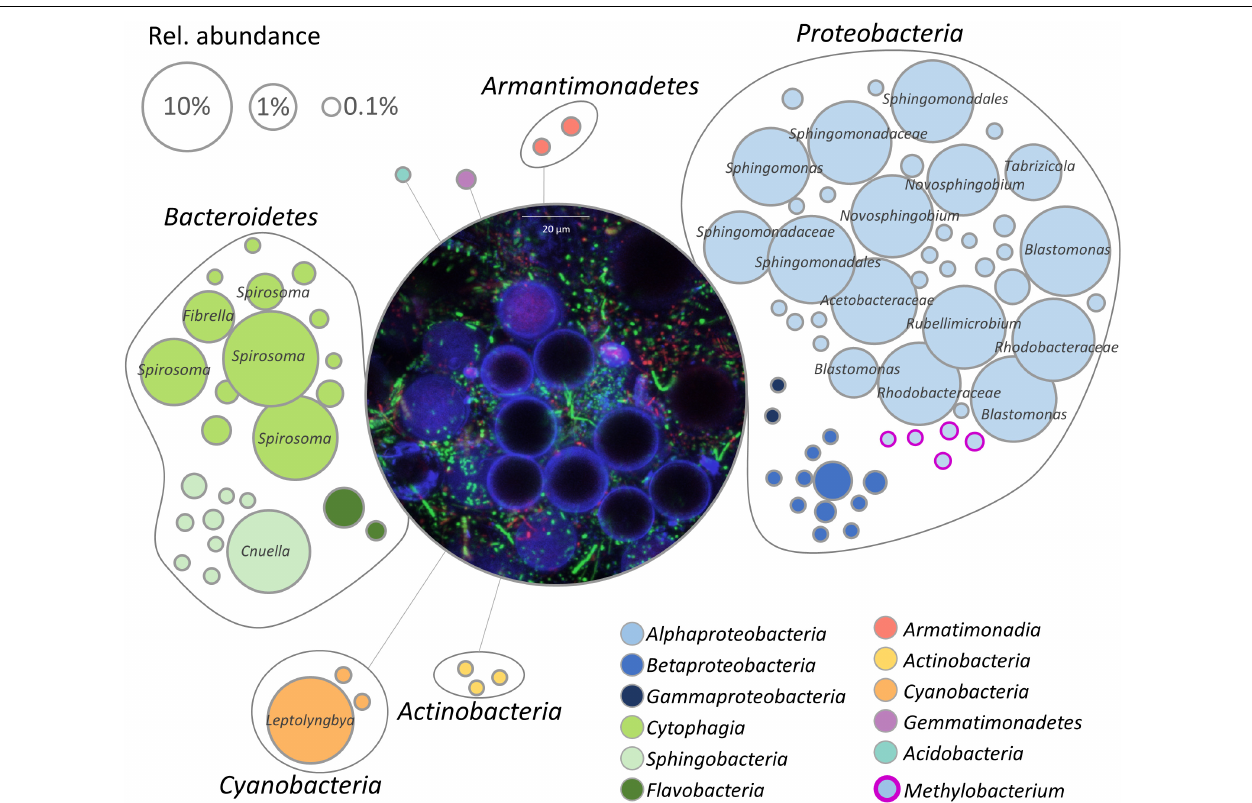
FIGURE 1 | Network visualization of the bacterial community within the biofilm. Each node represents a feature (99% cut-off level), whereas the node size corresponds to their relative abundance. Taxonomy of highly abundant features ( > 1%) is included. The central micrograph shows the natural microbial community within the biofilm after staining with the LIVE/DEAD bacterial viability kit in combination with calcofluor white (0.15%). Blue: algal cell wall (cellulose, chitin), green: viable bacterial cells, red: dead bacteria.